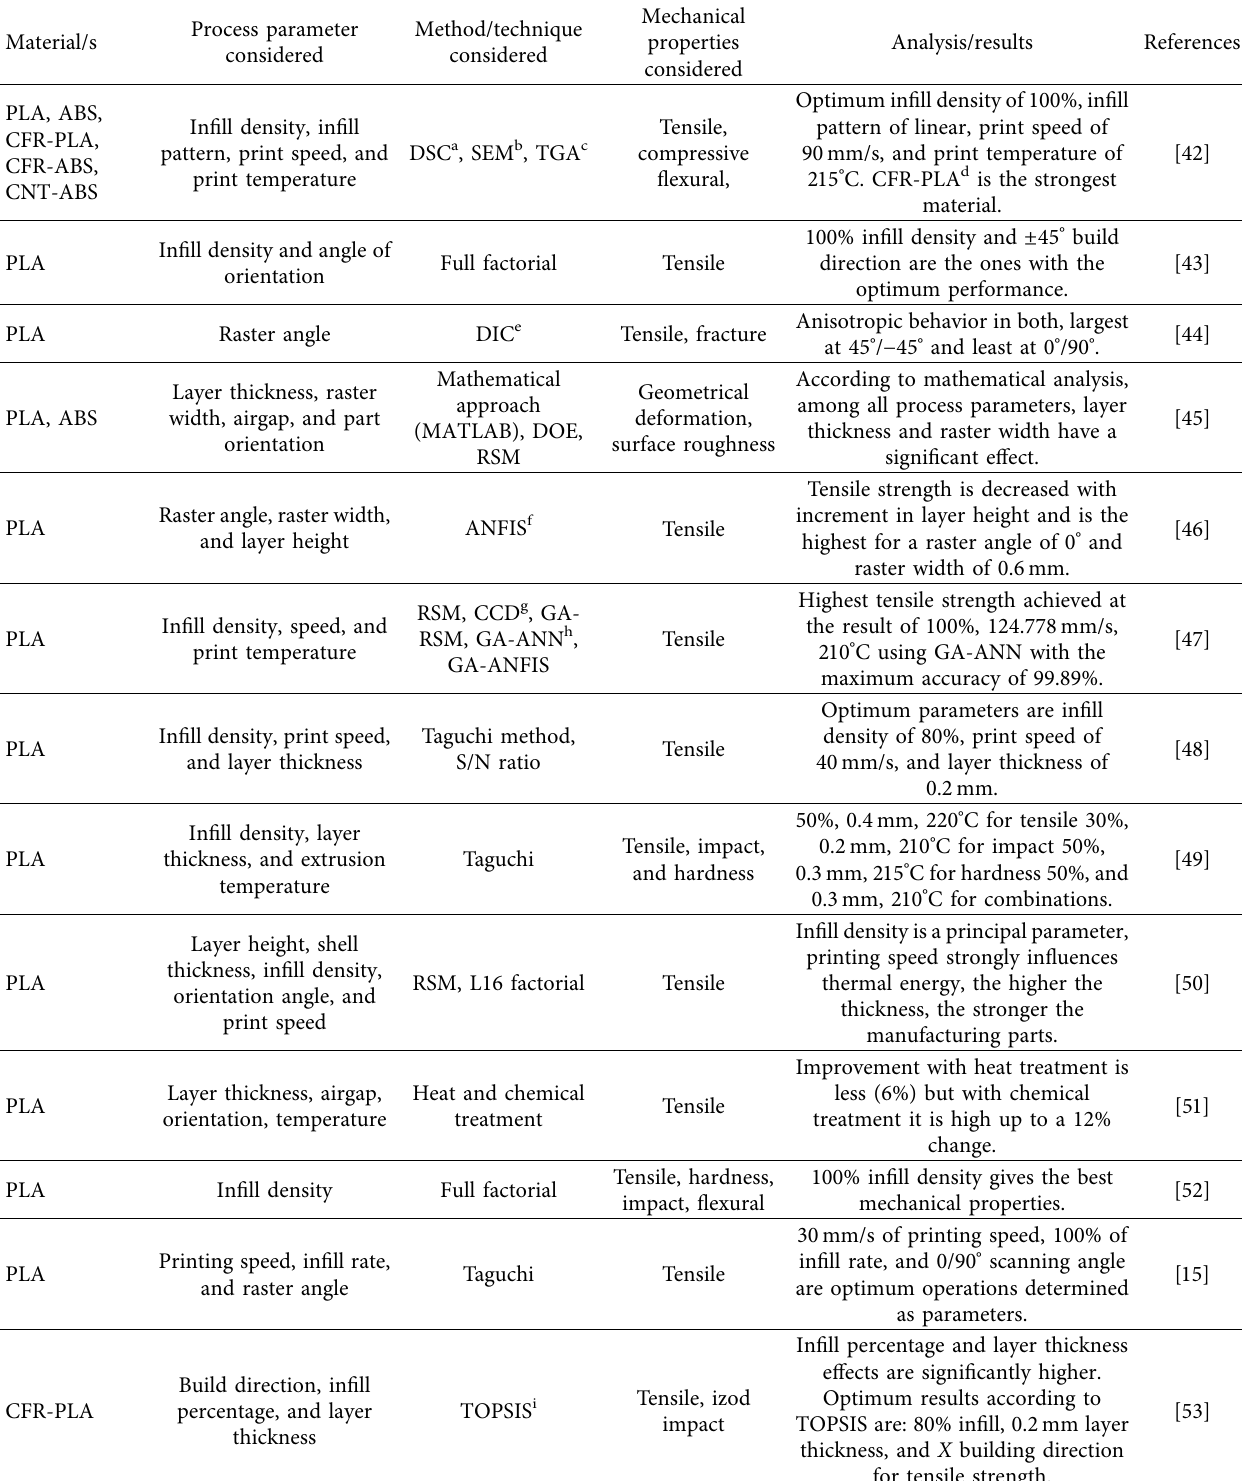
Table 1: Summary of review of earlier (2020 and above) works of